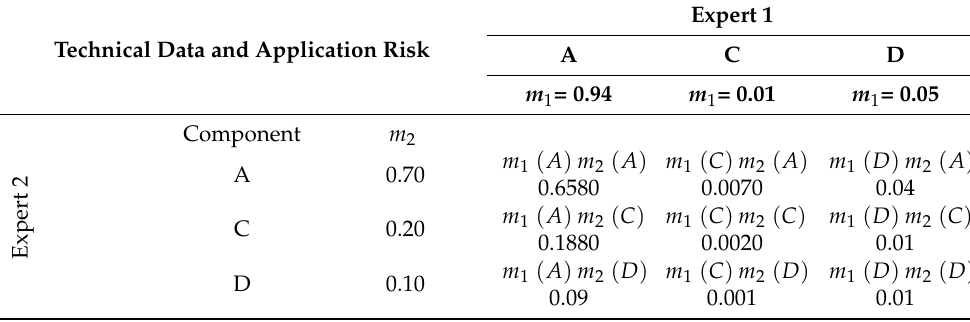
Table 6. Dempster combination of Expert 1 and Expert 2 for technical data and application risk.